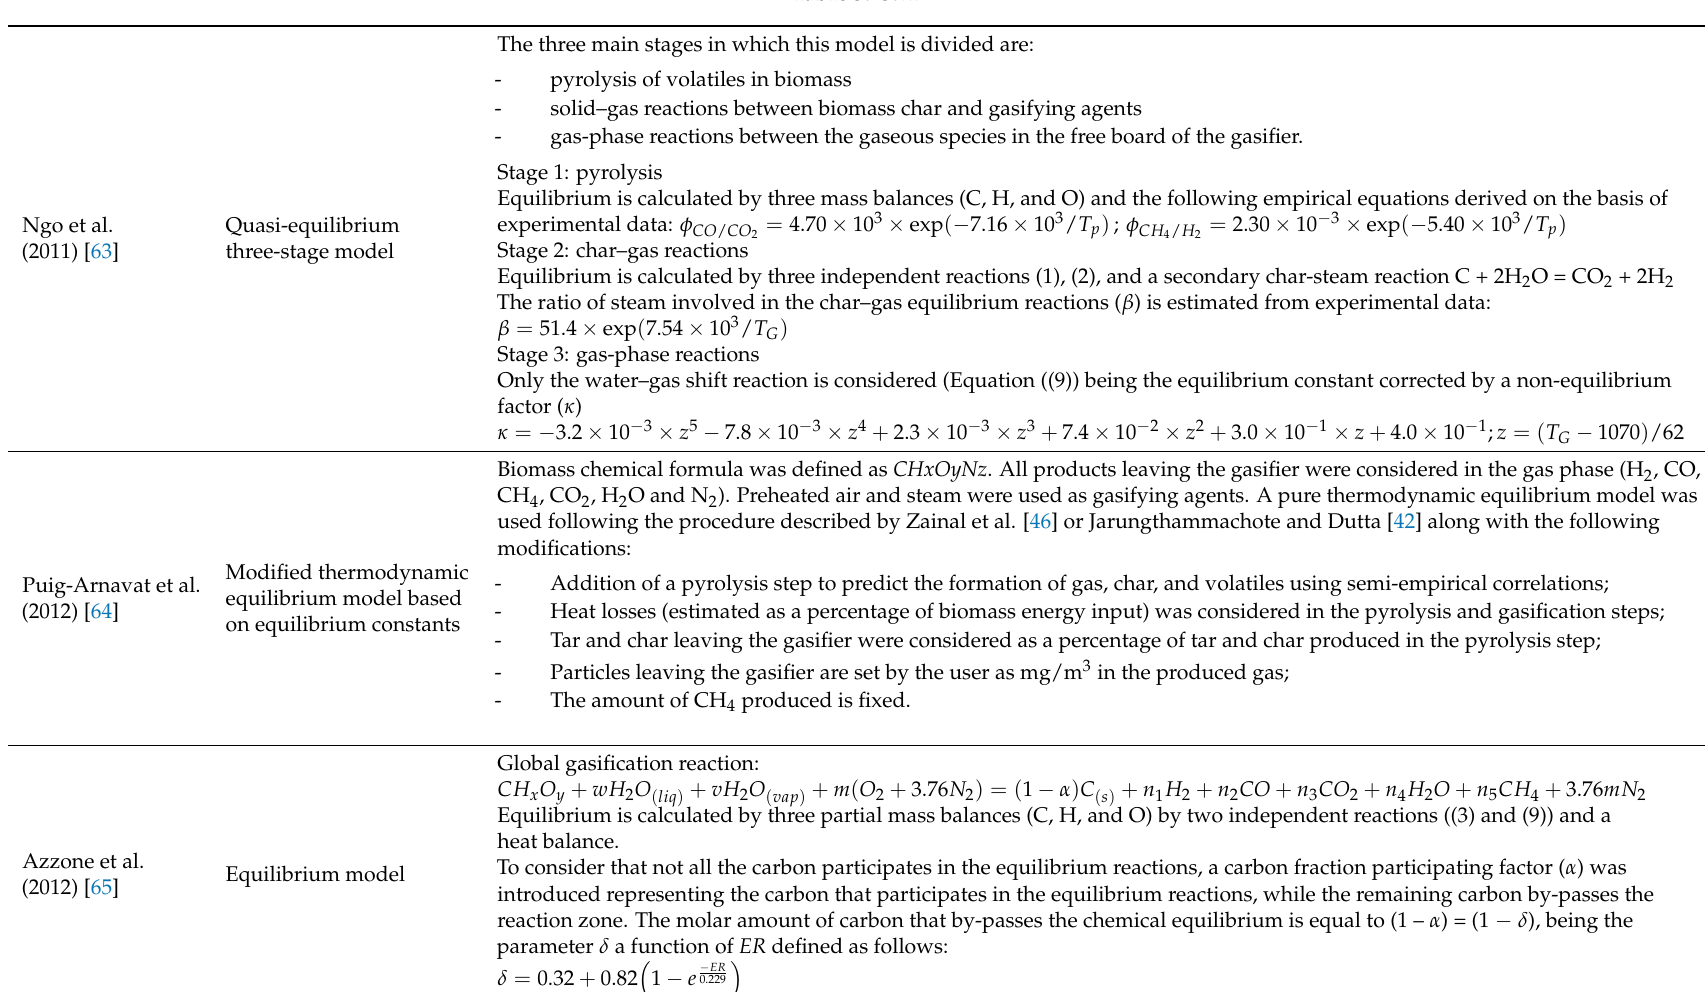
Stage 2: char–gas reactions